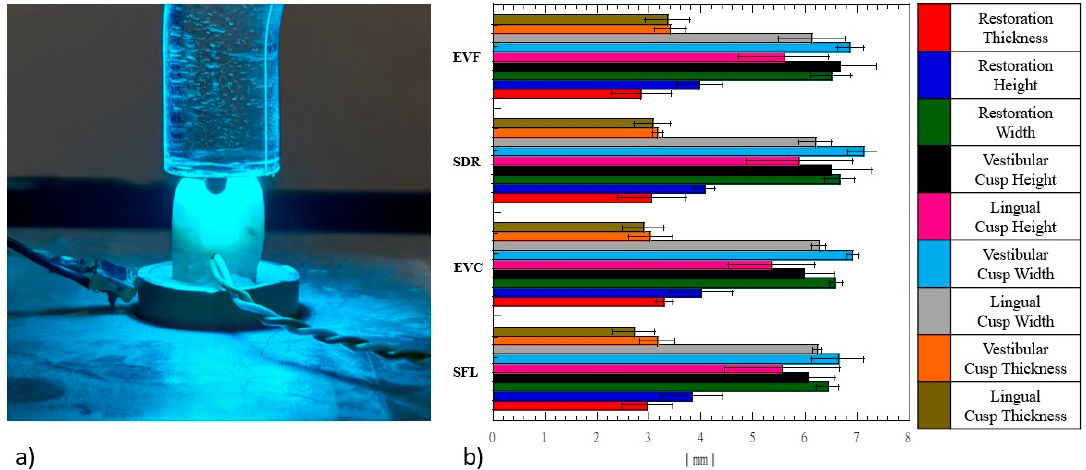
Figure 1. ( a ) Experimental set-up for the simultaneous measurement of light intensity and temperature levels occurring in mesio-occlusal-distal (MOD) cavities; ( b ) geometrical details of human premolars and MOD cavities ( b ).